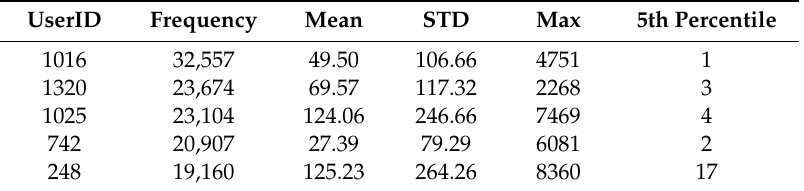
Table 4. User activity.